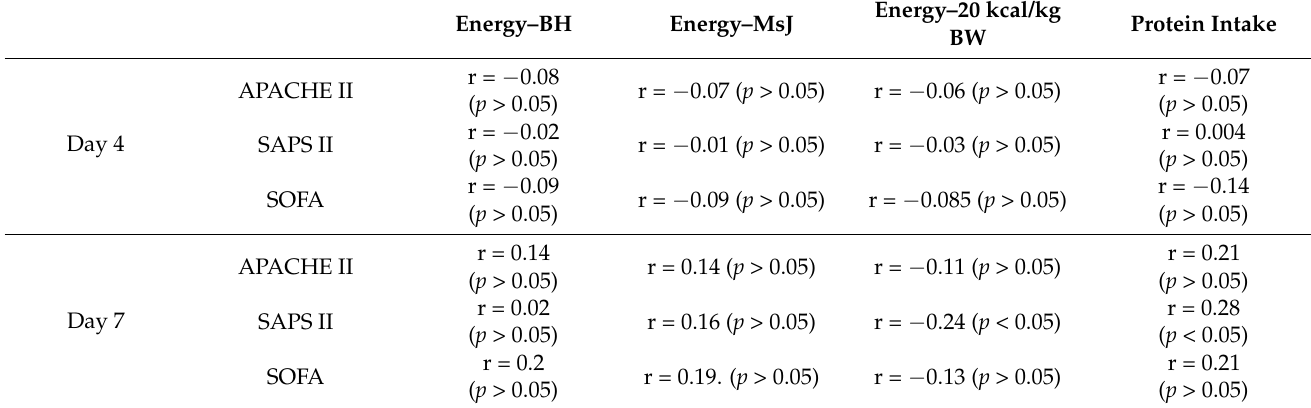
Table 4. Correlation between acuity of critical illness on ICU admission and delivery of calories and protein on day 4 and day